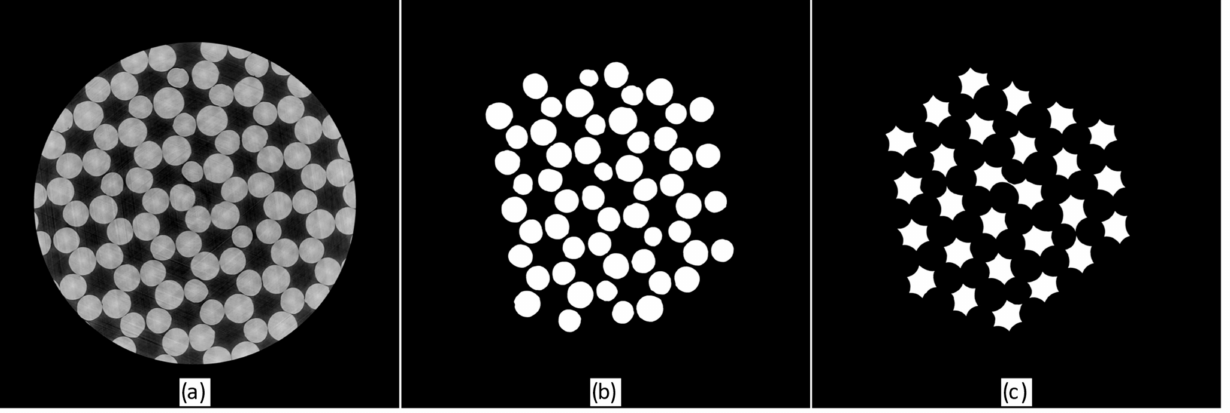
Figure A1. Extraction of ROI areas used to compute CNR metrics: ( a ) original XCT central slice of the bottom subvolume (contacting) of scan A4; ( b ) pellet foreground; ( c ) pore space